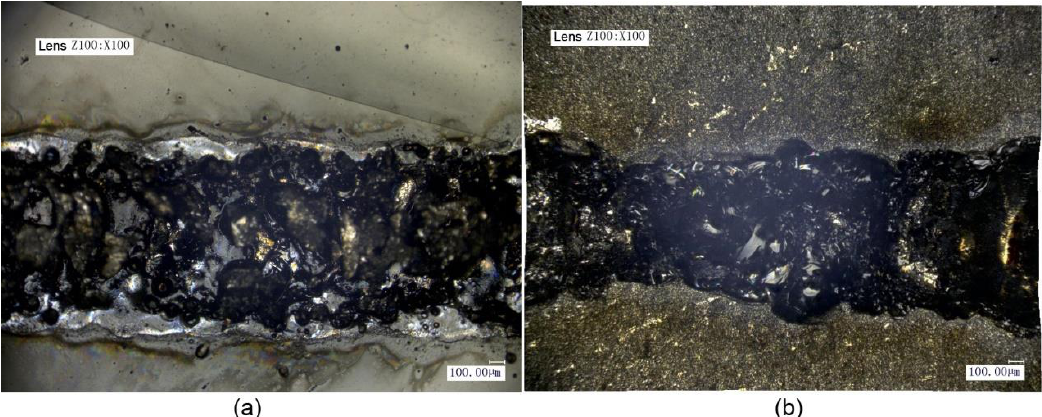
Figure 7. Micrographs of titanium alloy and high borosilicate glass using laser voltage for transmission welding of 460 V: ( a ) glass and ( b ) titanium alloy.